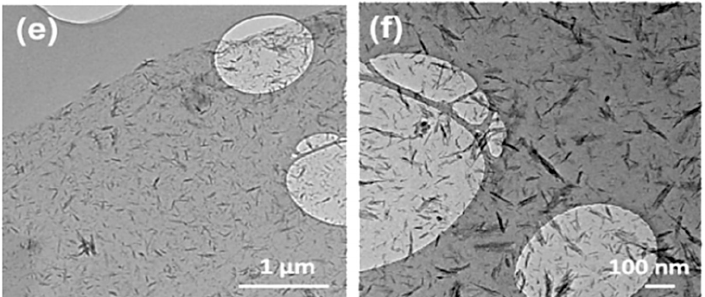
Figure 3. Characterizations of GO and GDOT: FE-SEM ( a ) and TEM ( b ) images of GO; TEM images of GDOT obtained within reaction time of 20 min ( c , d ) and 40 min ( e , f ).